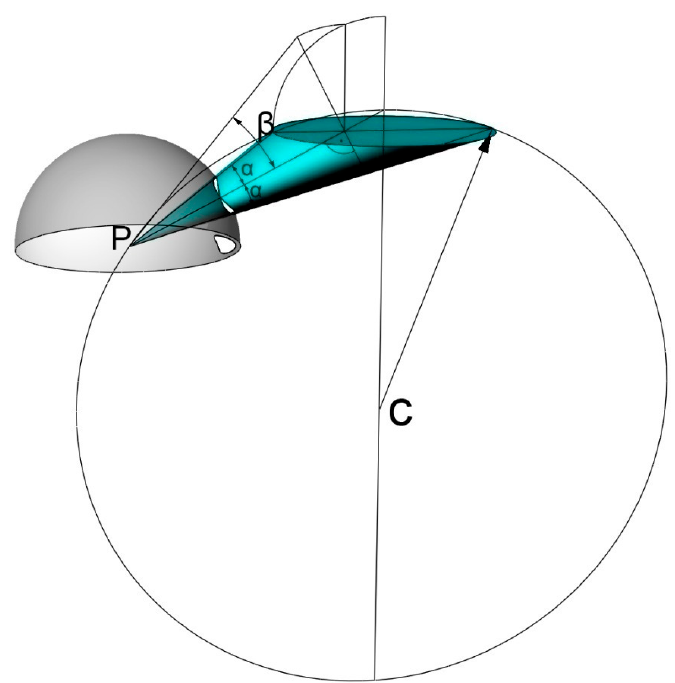
Figure A8. Procedure to find the main angles of the radiant cone. Figure A6. Procedure to find the main angles of the radiant